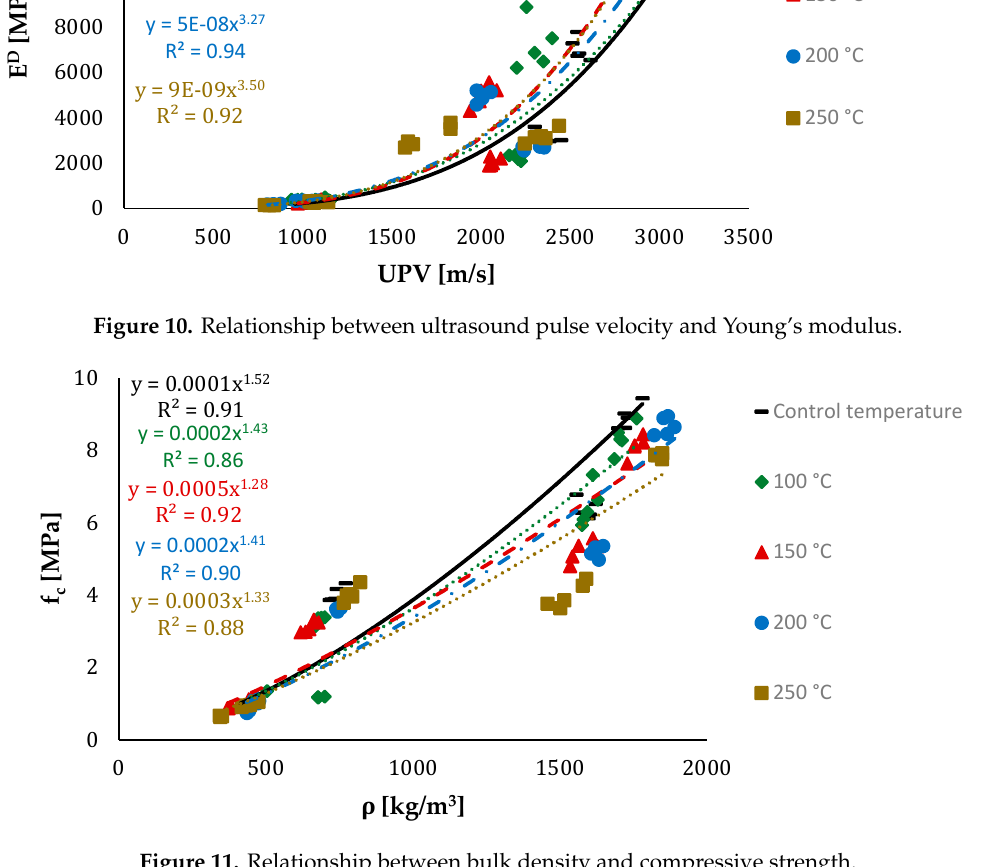
Figure 10. Relationship between ultrasound pulse velocity and Young’s modulus.